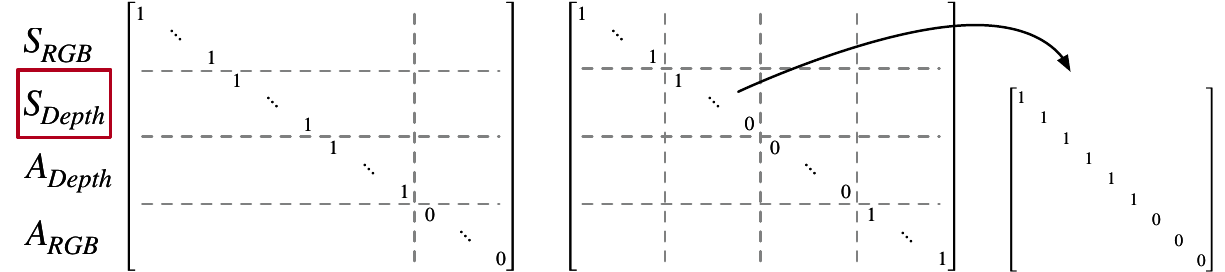
Figure 5. Improved mask matrices for multi-view relationship classifier. The first matrix is mask A , the second matrix is mask B , and the third one is part of mask B to process the multi-view depth spatial feature vector S Depth . Mask A and B can be divided into four diagonal matrices. Every diagonal matrix processes the corresponding component in the final combined feature